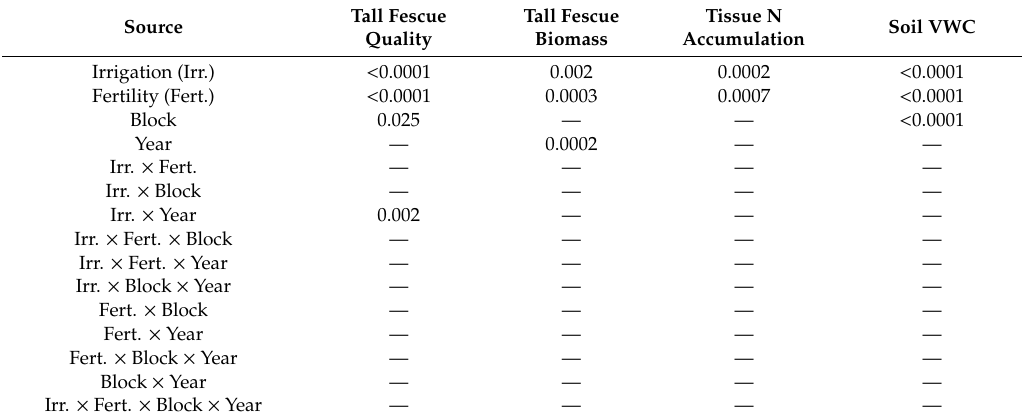
Table 3. Mixed model effects p ‐ values for spectral reflectance vegetation indices using a multispectral and hyperspectral radiometer for all dates of the trial.